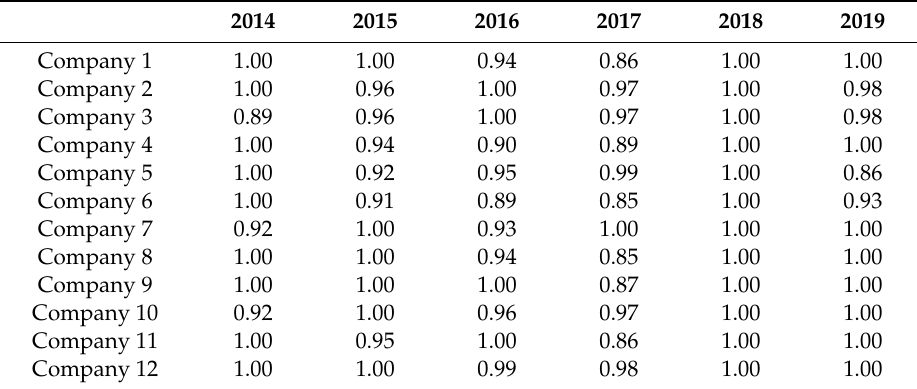
Table 10. Average e ffi ciency in BCC model for each